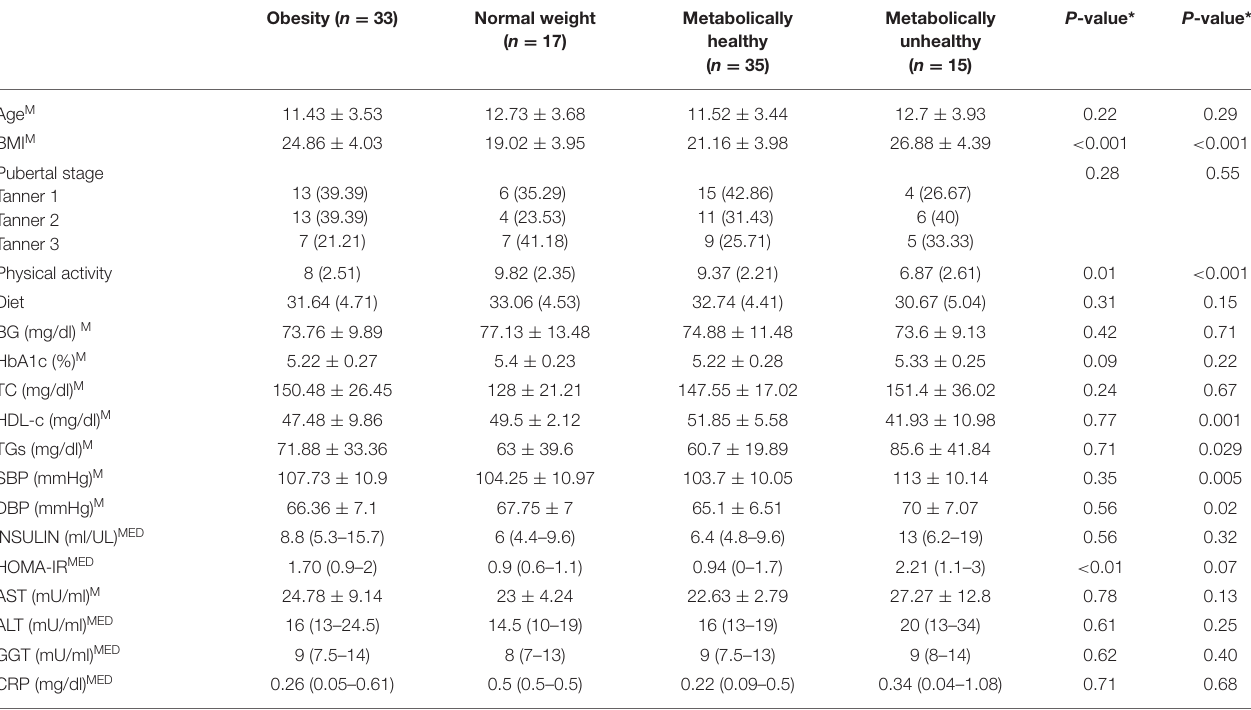
TABLE 1 | Clinical and biochemical characteristics of enrolled subjects, according to BMI and metabolic status.